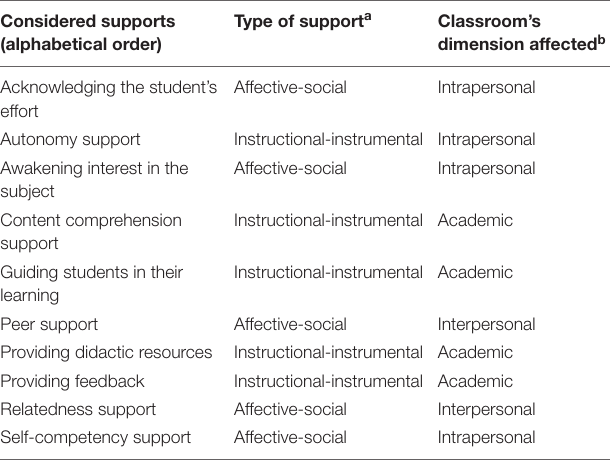
TABLE 1 | Characteristics of the considered teacher support variables. Considered supports (alphabetical